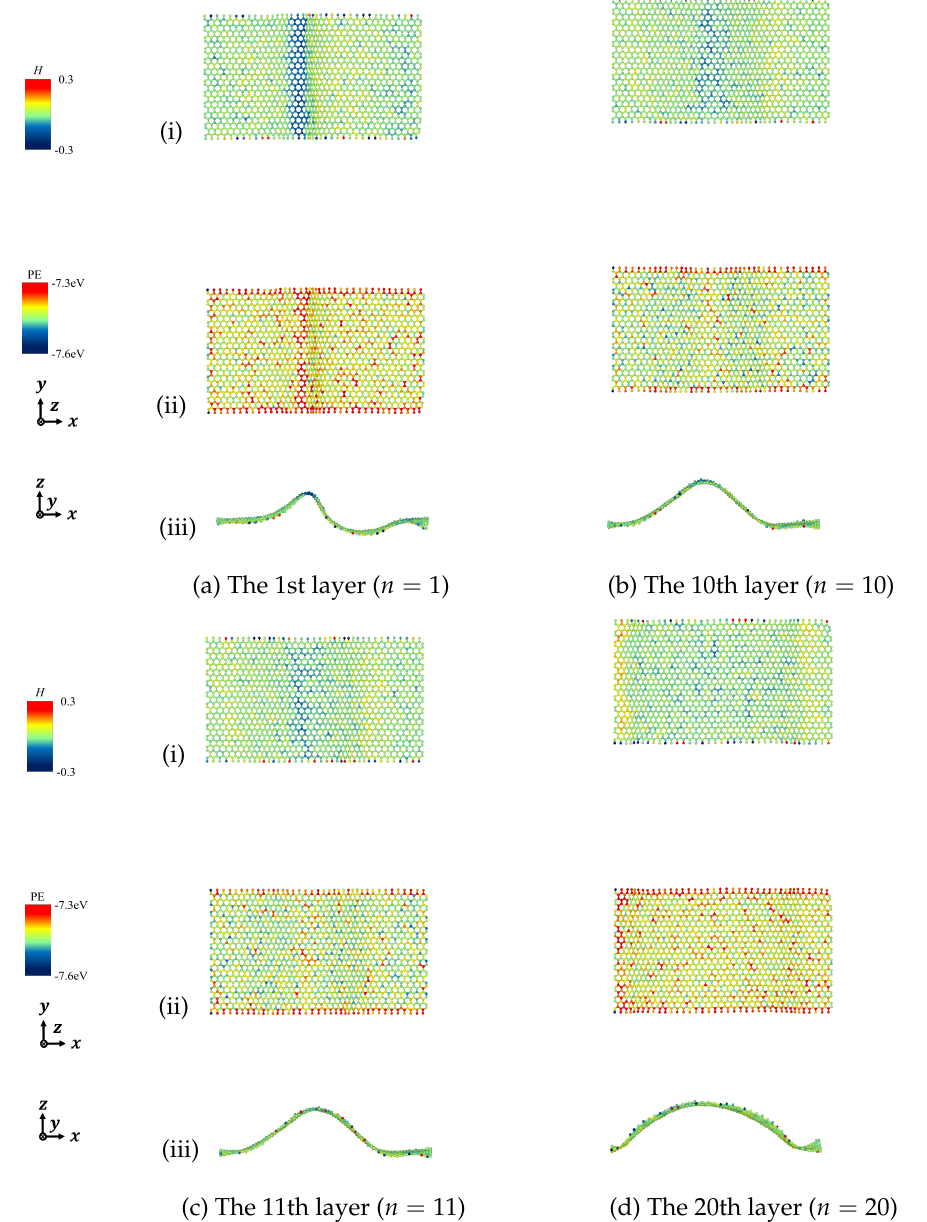
Figure 13. Mean curvature and site potential energy of curved surface of zigzag graphite under compression ε = 0.10. (i) Site mean curvature, (ii) Site potential energy, and (iii) Mean curvature with deformation.